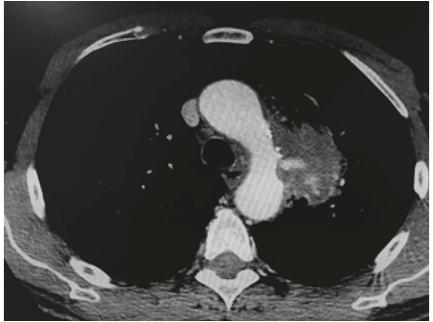
Figure 2: CT depicted an aortobronchial fistula with intrapul- monary hematoma.